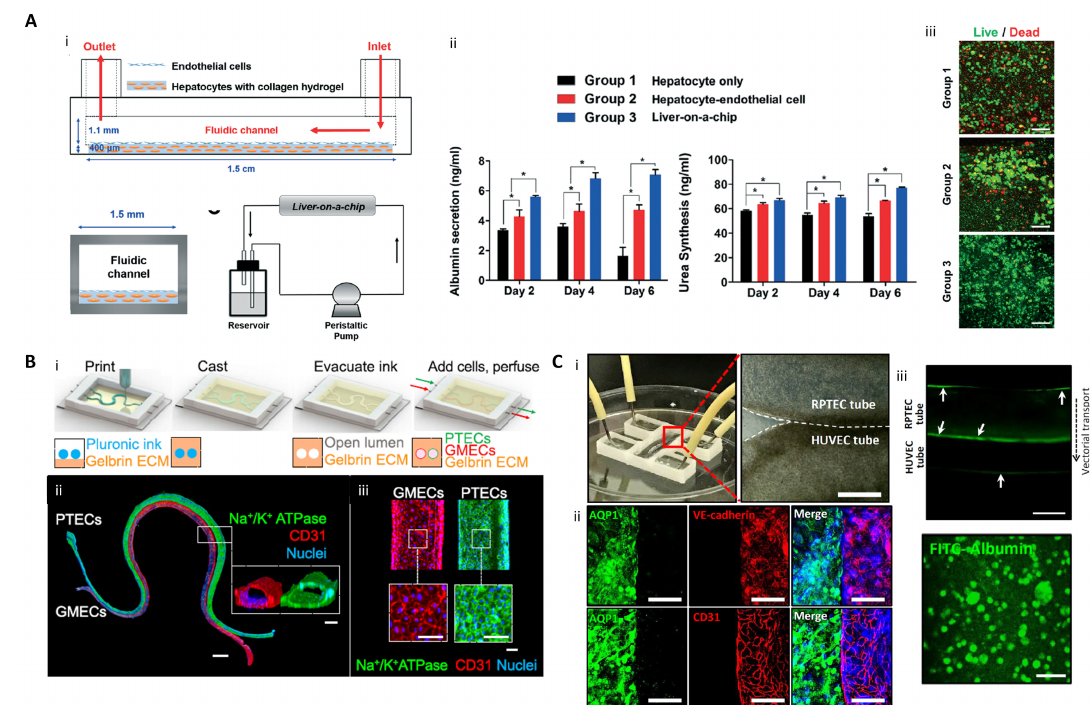
Figure 4. 3D printed liver-on-a-chip and kidney-on-a-chip. ( A ) 3D printing-based liver-on-a-chip (i) Schematic diagram of one-step fabricated liver-on-a-chip with a vascular channel; (ii) Liver function analysis with albumin and urea tests (* p < 0.05); (iii) hepatocyte viability on Day 6 (scale bar: 100 µ m) (reproduced with permission from ref [94]; published by The Royal Society of Chemistry). ( B ) 3D vascularized proximal tubule on a chip (3D VaPT) model; (i) Fabrication process of the 3D VaPT model; (ii) The fluorescence image of the 3D VaPT model. PTECs are presented in blue, GMECs in red, and nuclei in blue (Scale bar: 1 mm). The cross-sectional views of each microchannel (scale bar: 100 µ m); (iii) Magnification of PTECs and GMECs channel in the 3D VaPT model (scale bar: 100 µ m). ( C ) 3D cell-printed renal proximal tubule-on-a-chip with tubular RTPEC and HUVEC constructs. (i) Microfluidic system and dual tubular constructs of the chip after fabrication; (ii) Fluorescence image of renal proximal tubular markers (AQP1, aquaporin 1), and vascular markers (vascular endothelial (VE)-cadherin, and CD31) in the chip after maturation. The renal proximal tubular marker is presented in green, vascular endothelial markers are red, and nuclei are blue (scale bar: 100 µ m); (iii) Albumin reabsorption between RTPEC and HUVEC tube via vectorial transport. Arrows indicate the intracellular accumulating albumin within the RPTEC and sidewall of the vessel (scale bar: 400 µ m) (reproduced with permission from ref [123]; copyright 2020